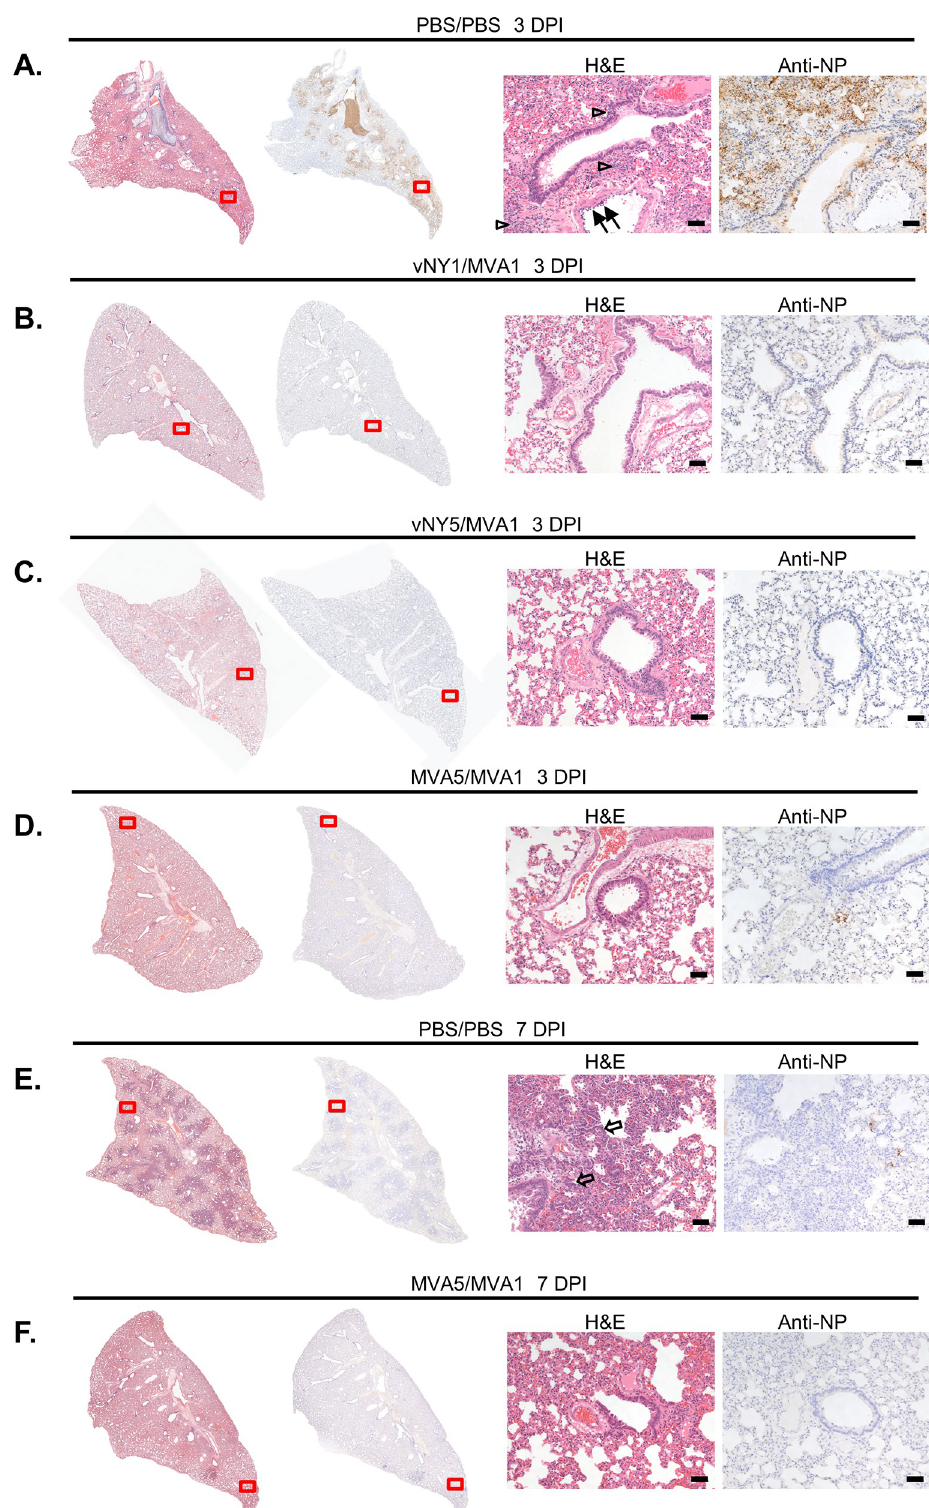
Fig 6. Lung pathology and immunohistochemistry of hamsters after SARS-CoV-2 challenge. (A). H&E and immunohistochemical staining of lungs of the placebo (PBS/PBS) infection hamster group at 3 d.p.i.. H&E staining showed severe bronchointerstitial pneumonia with the alveolar walls thickened by edema, capillary congestion and